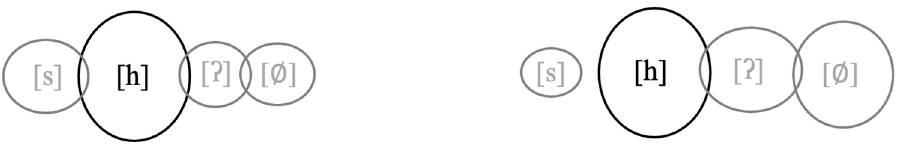
Figure 7. Coda [s] lenition continuum in Nicaraguan Spanish. More educated younger speaker ( left ) and less educated or older speaker ( right ) adapted from (Chappell 2015).